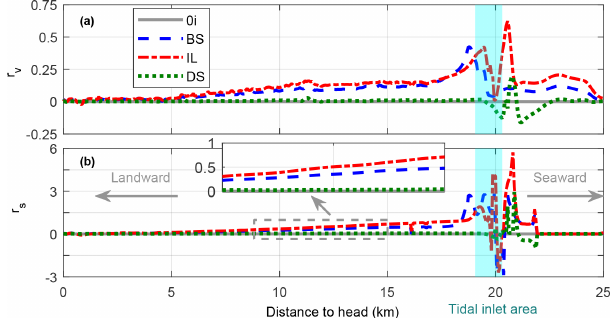
Figure 11. Longitudinal variations of cross-sectionally averaged flow velocity (a) and sediment transport (b) compared to the 0i case at the high tide of the first